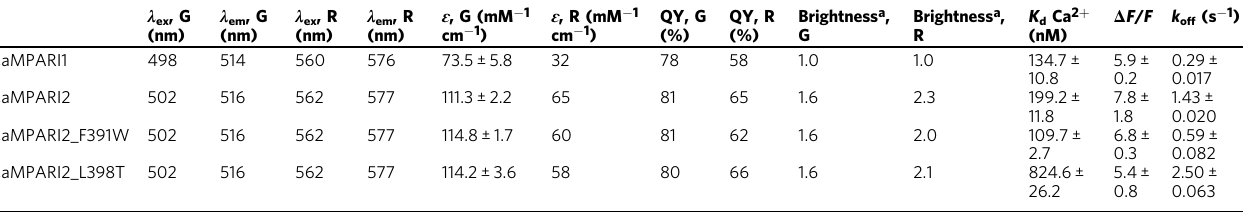
Table 1 Photophysical properties of CaMPARI1, CaMPARI2, CaMPARI2_F391W, and